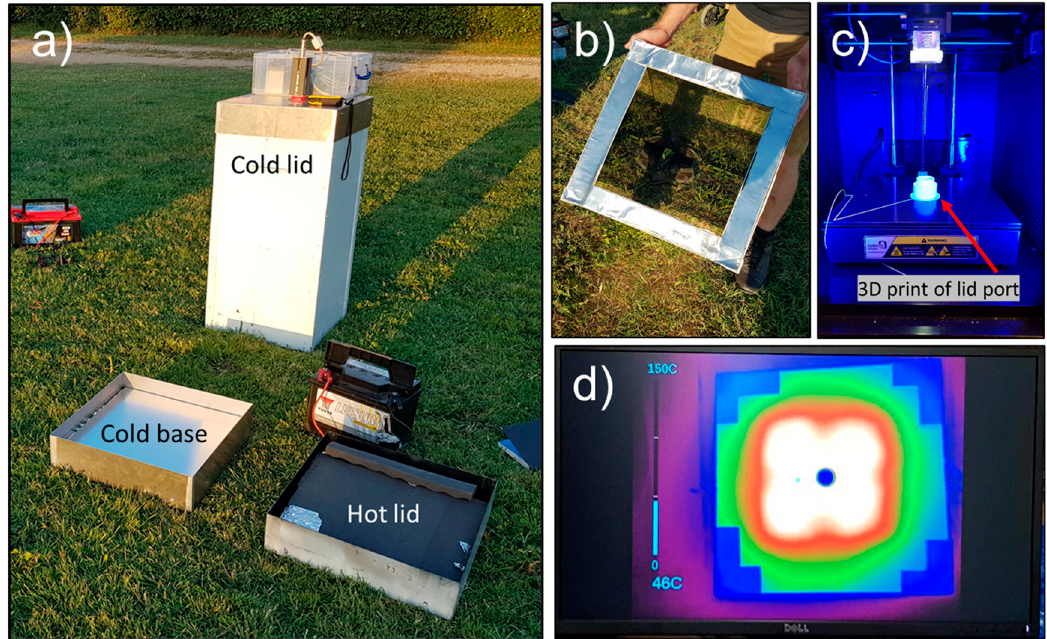
Figure 3. ( a ) Insulated emissivity box with the cold base and battery-powered hot lid. Details include ( b ) internal walls of highly polished aluminium, ( c ) a 3D printed 5° radiometer port for consistent off-centre angled sampling to avoid the “Narcissus” effect, and ( d ) evenly distributed electronic heating pads on the hot lid enabling heating up to at least 60 °C when combined with the heating tray.